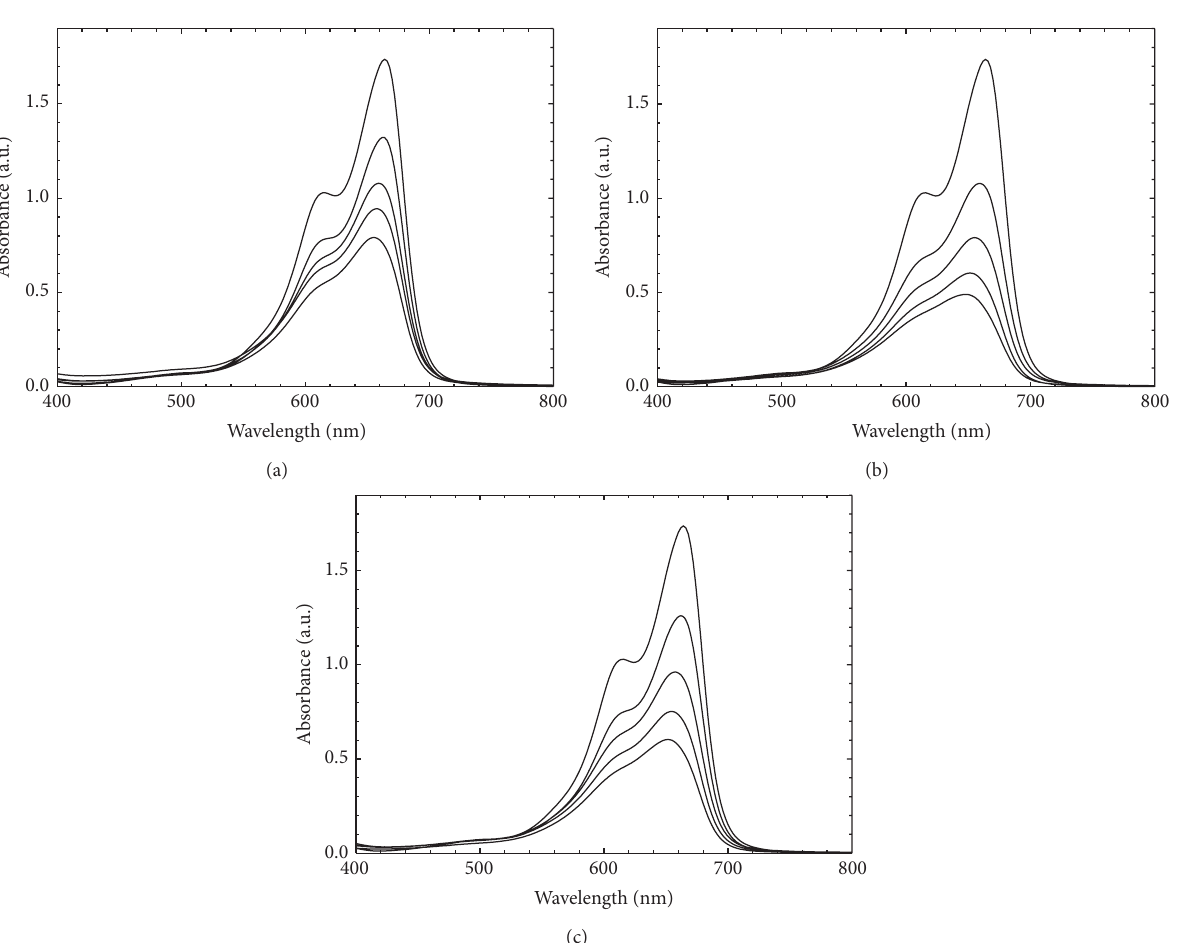
Figure 6: The photocatalytic degradation activity of MB concentrations for (a) ZnO NWs, (b) NiO-decorated ZnO NCs, and (c) NiO- decorated ZnO NCs recycled.